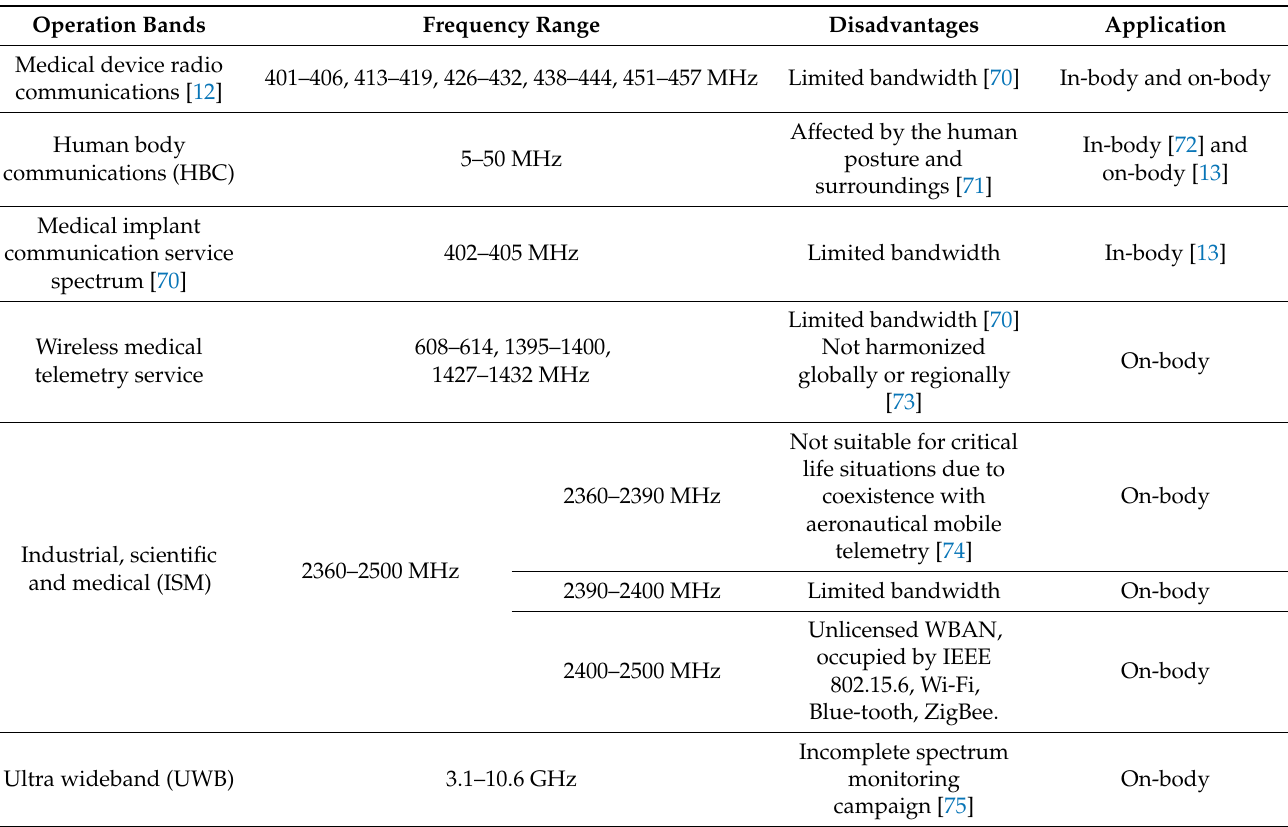
Table 8. Medical body area networks’ operation